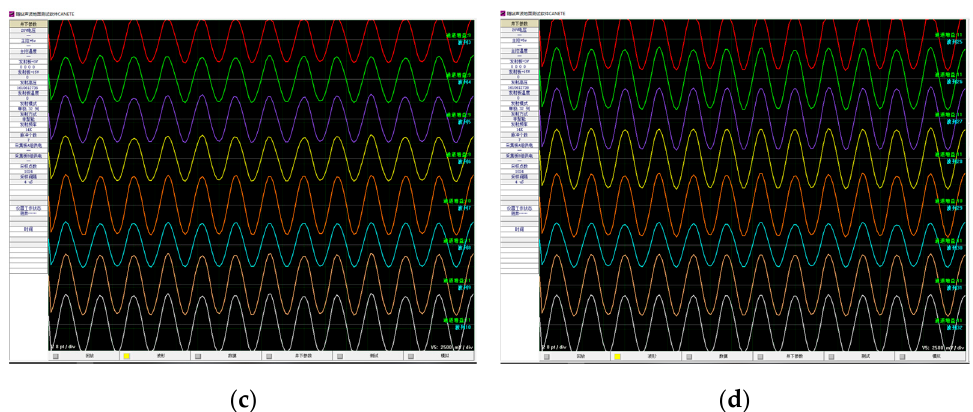
Figure 13. Test waveforms of axial transducer data trace. ( a – d ) stands for orientation A, B, C, and D, respectively.